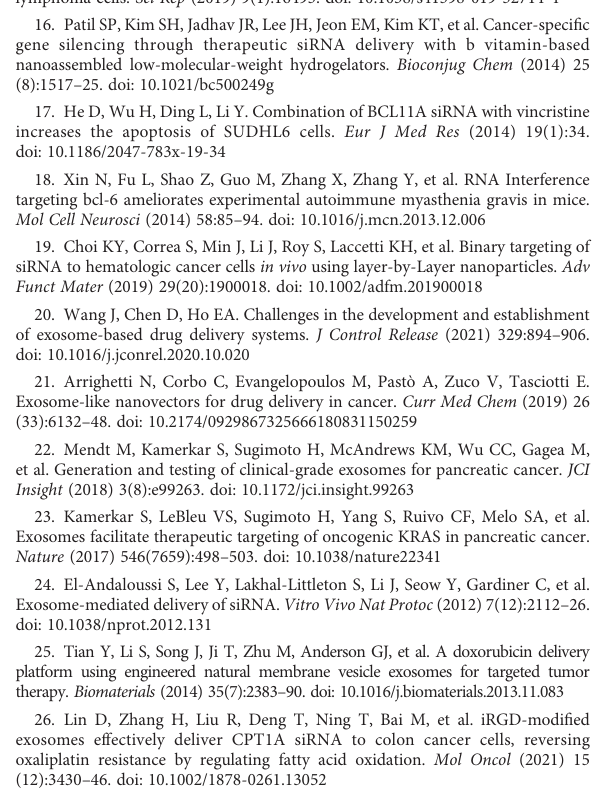
SUPPLEMENTARY FIGURE 1 NTA analysis for blank-Exo and iRGD-Exo. (A, B) Identi fi cation of exosomes derived from DCs (blank-Exo) and DCs transfected with iRGD-Lamp2b plasmids (iRGD-Exo) by NTA analysis. SUPPLEMENTARY FIGURE 2 iRGD-Exo could be internalized by OCI-Ly8 cells. (A, B) Confocal microscopy images of colocalization of exosomes in OCI-Ly8 cells. Nucleus was stained with DAPI (blue), cell membrane was stained with DiO (green), exosomes were labeled with FM4-64 (red). Scale bar, 50 m m. **P < 0.01. All tests were repeated in triplicate.